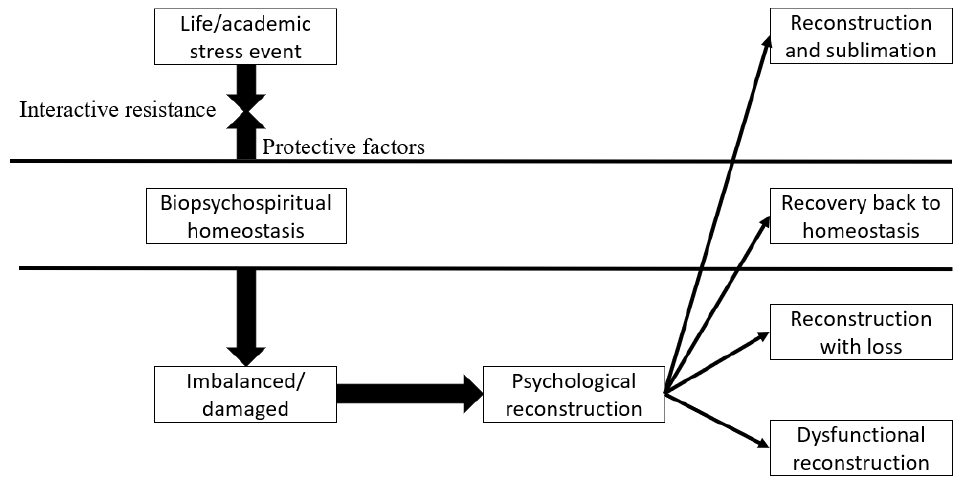
Figure 1. Model of psychological resilience [31].